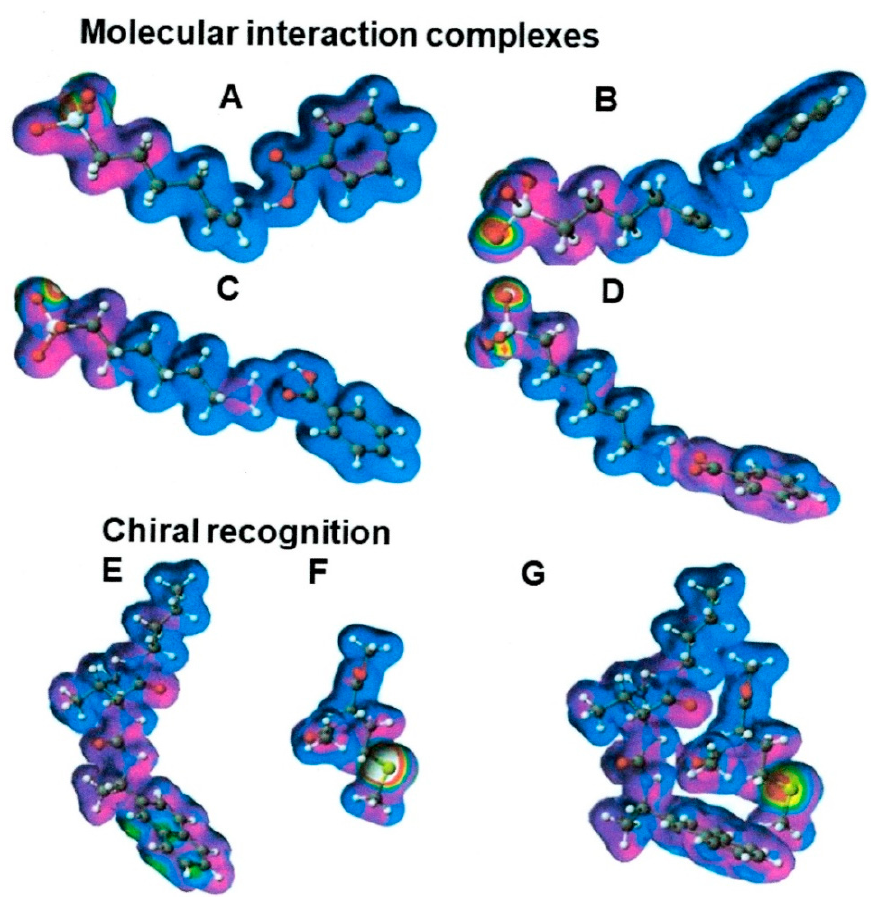
Figure 3. Molecular interaction form and imidazolium ligand, A: HxNy and benzoic acid complex. B: HxNy and ionized aniline complex. C: C6NH 2 and benzoic acid complex; D: C6N + H 3 and ionized benzoic acid ion-pair formation. G: enantiomer recognition of E ( N-(R) -1-( α -naphtyl)ethylamino carboxyl-( S )-valylaminobutane) with F: (( R ) -N -acetylmethionine) ([15], p. 185). For an explanation of